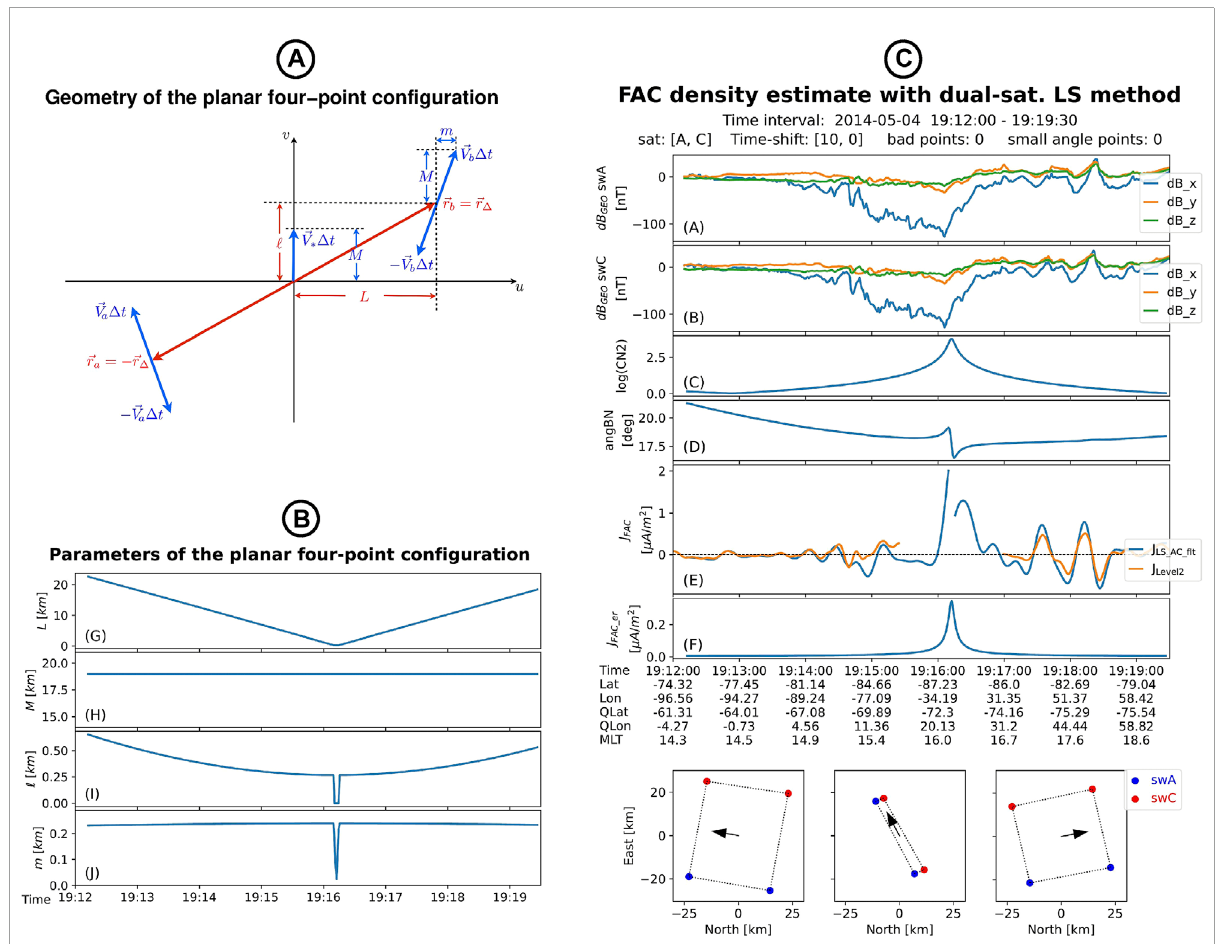
FIGURE 2 FAC density estimate by dual-satellite LS method. (A) : Geometry of the planar four-point configuration in the dual-satellite methods. The different parameters that characterizes the configurations are L (half cross track separation), M (half along track separation), ℓ (half orbital lag) and m , with ϵ = m / M describing the deviation of satellite trajectories from parallel orbits. Taken from Vogt et al. (2013). (B) : Parameters of the planar four-point configuration for the event shown on the right. The evolution along the orbit of L , M , ℓ , and m are presented in panels G–J. (C) : Standard plot generated by the j2satLS algorithm. From top to bottom the figure shows (A and B) the Swarm magnetic field perturbation in the GEO frame, (C) the logarithm of the condition number, (D) the angle between B and the direction normal to the quad, (E) comparison between the dual-satellite LS FAC estimation (blue) and the Level-2 product (orange), and (F) the error level in FAC density estimation. At the bottom, the quad configuration at three instances (i.e. start time, stop time, and at the middle of the interval) is presented as projection on the North-East plane of the local NEC